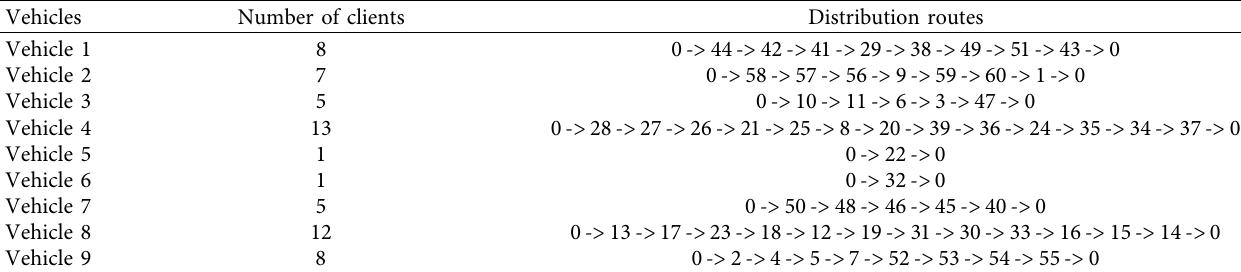
Table 9: Vehicle distribution routes considering transport costs only. Vehicles